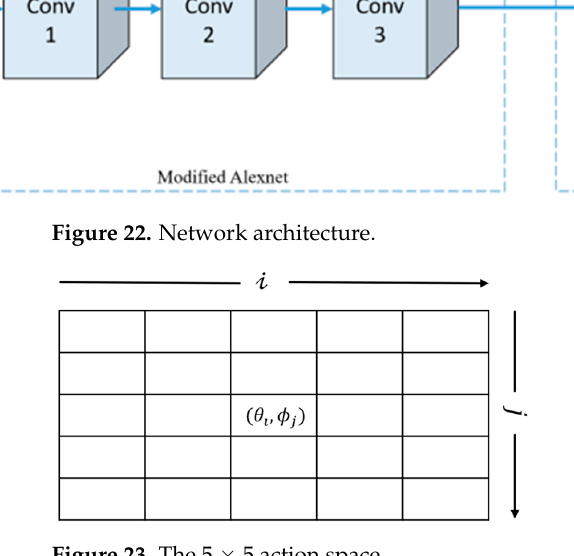
Figure 23. The 5 × 5 action